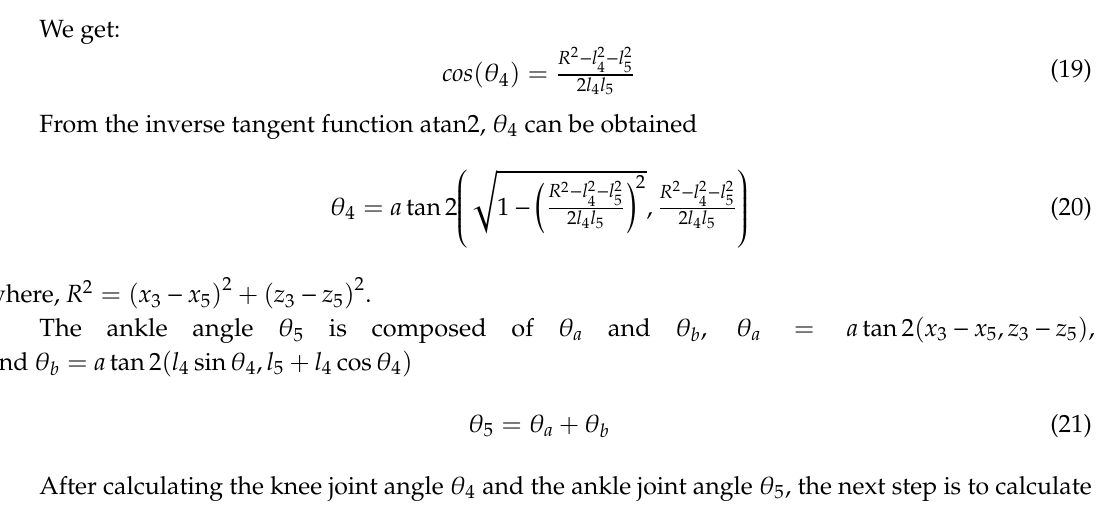
Figure 9. Coronal geometric relationship diagram.